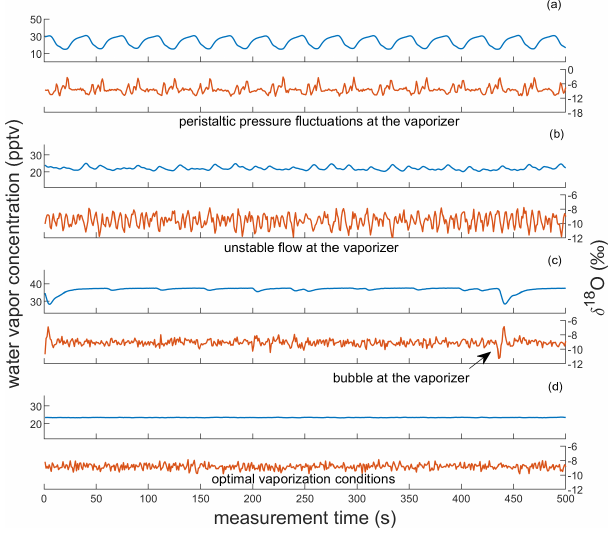
Figure 3. Observations of vapor quality as real-time indicators of vaporizer performance. Each panel shows corresponding observa- tions of water vapor concentration and δ 18 O of SW2, reported in parts per thousand vapor (pptv) and ‰, respectively. Panels (a) and (b) show observations indicative of imbalanced vaporizer con- ditions for large and small pressure imbalances, respectively. Pan- els (c) and (d) show observations indicative of acceptable vaporizer performance. Though both include low-variability observations of δ 18 O ( σ < 0.3‰) and of water vapor concentration, (c) also in- cludes microbubble interruptions at the vaporizer (e.g., at 5 and 440s). Panel (d) indicates optimal vaporizer performance. Note that the vertical scaling of (a) is different from the other